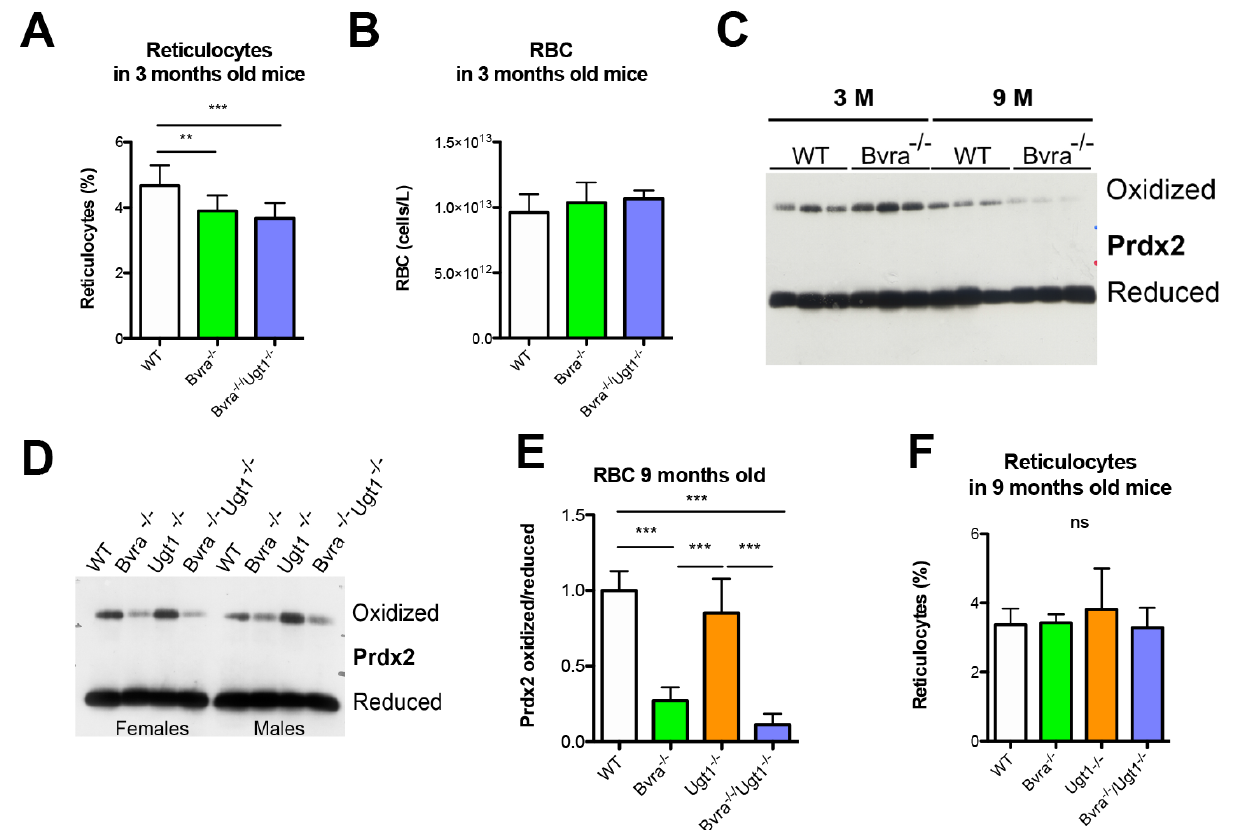
Figure 4. Bvra deficiency results in increase in oxidized peroxyredoxin-2 and lower erythrocyte turn over in 3- but not in 9-months-old mice. ( A ) The percentage of reticulocytes, as determined by acridine orange staining of blood in 3-month-old mice. One-way ANOVA, p = 0.0006, F = 9.982, Bonferroni post-test, WT vs. Bvra −/− Ugt1 −/− , p ≤ 0.001; ( B ) RBC counts in 3-month-old mice. One-way ANOVA, p = 0.1709, F = 1.887, ns; ( C ) Western blot of oxidized and reduced peroxiredoxin 2 (Prdx2 in erythrocytes of 3- and 9-months-old WT and Bvra −/− mice. ( D ) Western blot of oxidized and reduced Prdx2 in erythrocytes of 9-months-old WT, Bvra −/− , Ugt1 −/− and Bvra −/− Ugt1 −/− mice; ( E ) densitometric quantification of the Western blot giving the ratio oxidized/reduced Prdx2. Two-way ANOVA. Interaction genotype-gender ns; genotype, ***, p < 0.0001; gender, ns. Bonferroni post-test Bvra −/− vs. WT or Ugt1 −/− ***, p < 0.0001; Bvra −/− Ugt1 −/− vs. WT or Ugt1 −/− ***, p < 0.0001; WT vs. Ugt1 −/− , ns; ( F ) percentage of reticulocytes, as determined by acridine orange staining of blood from 9-month-old mice. One-way ANOVA, p = 0.4202, F = 0.9692, ns. Bonferroni tests: **, p ≤ 0.01; ***, p ≤ 0.001.